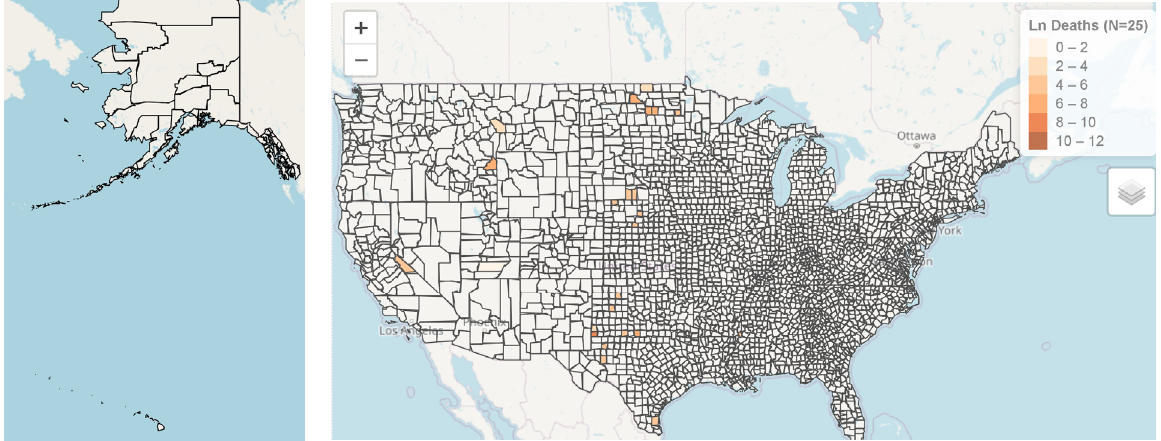
Figure 7. Logarithm of the Sum of COVID-19 Deaths (+1) for N = 25 counties where the mean is greater than the variance and with p < 0.05.